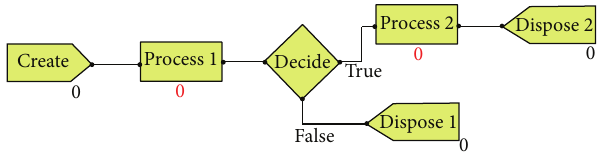
Figure 1: Basic modules used in Arena.